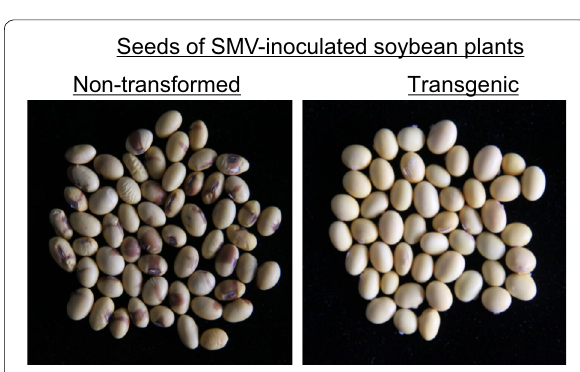
Fig. 5 Investigation of seed coat mottling from transgenic plants and non-transgenic